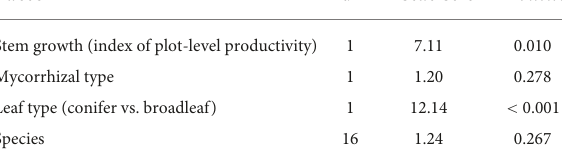
TABLE 2 Results of a ANCOVA model examining the effect of productivity, tree species identity, and tree functional type on soil C stocks.